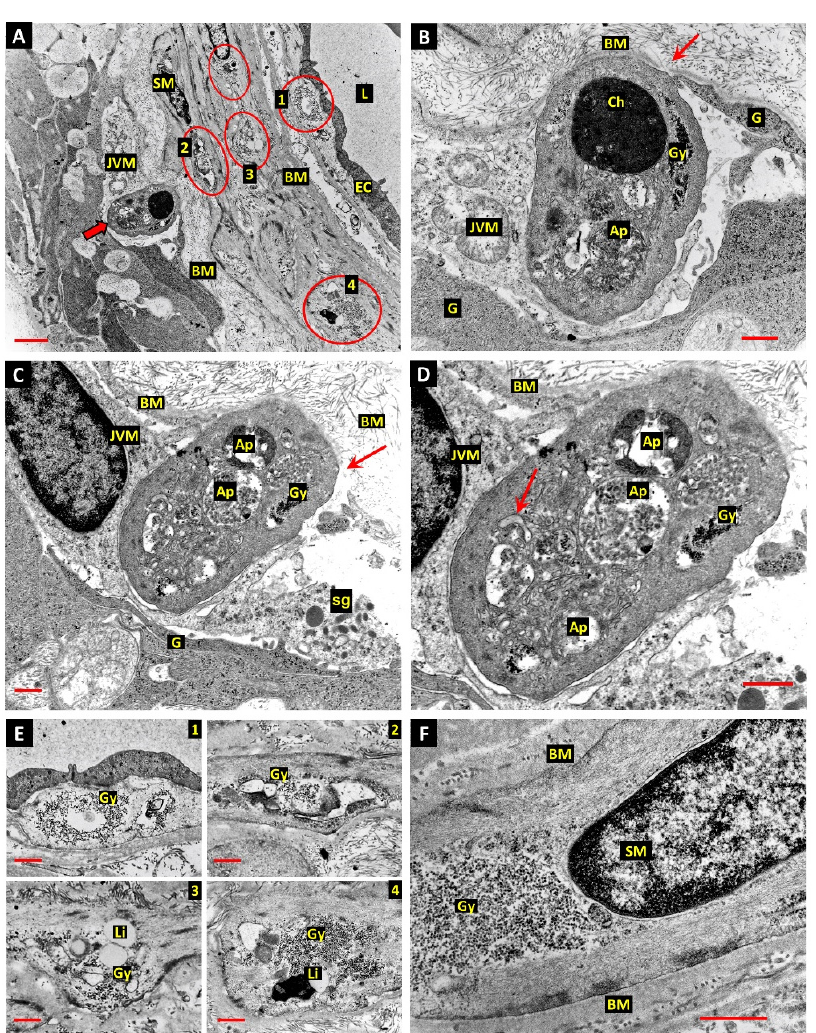
Figure 2. ( A ) The wall of a retinal arteriole from a diabetic donor eye shows a JVM cell during engulfment of a cell thought to be engaged in either apoptotic or autophagy-dependent cell death (thick arrow). Glycogen deposits in smooth muscle cells (SM) are circled—see enlargements in panel E below. Bar 3.0 µm. ( B ) The JVM cell appears to have drawn the dying cell through a break in the outer lamina of the vascular BM (arrow, also in panel C). The cytoplasm of the dying cell contains autophagosomes containing degraded chromatin (Ch), other more typically heterogeneous material (Ap) and coarse aggregates of glycogen granules (Gy). Glial process—G; bar 1.0 µm. ( C ) This profile shows the nucleus of the phagocytic JVM cell and a group of the presumptive storage granules in the JVM cytoplasm adjacent to the forming phagosome. Glial process—G; storage granules—sg; bar 1.0 µm. ( D ) Enlargement of the profile of a dying cell in panel C shows a C-shaped double